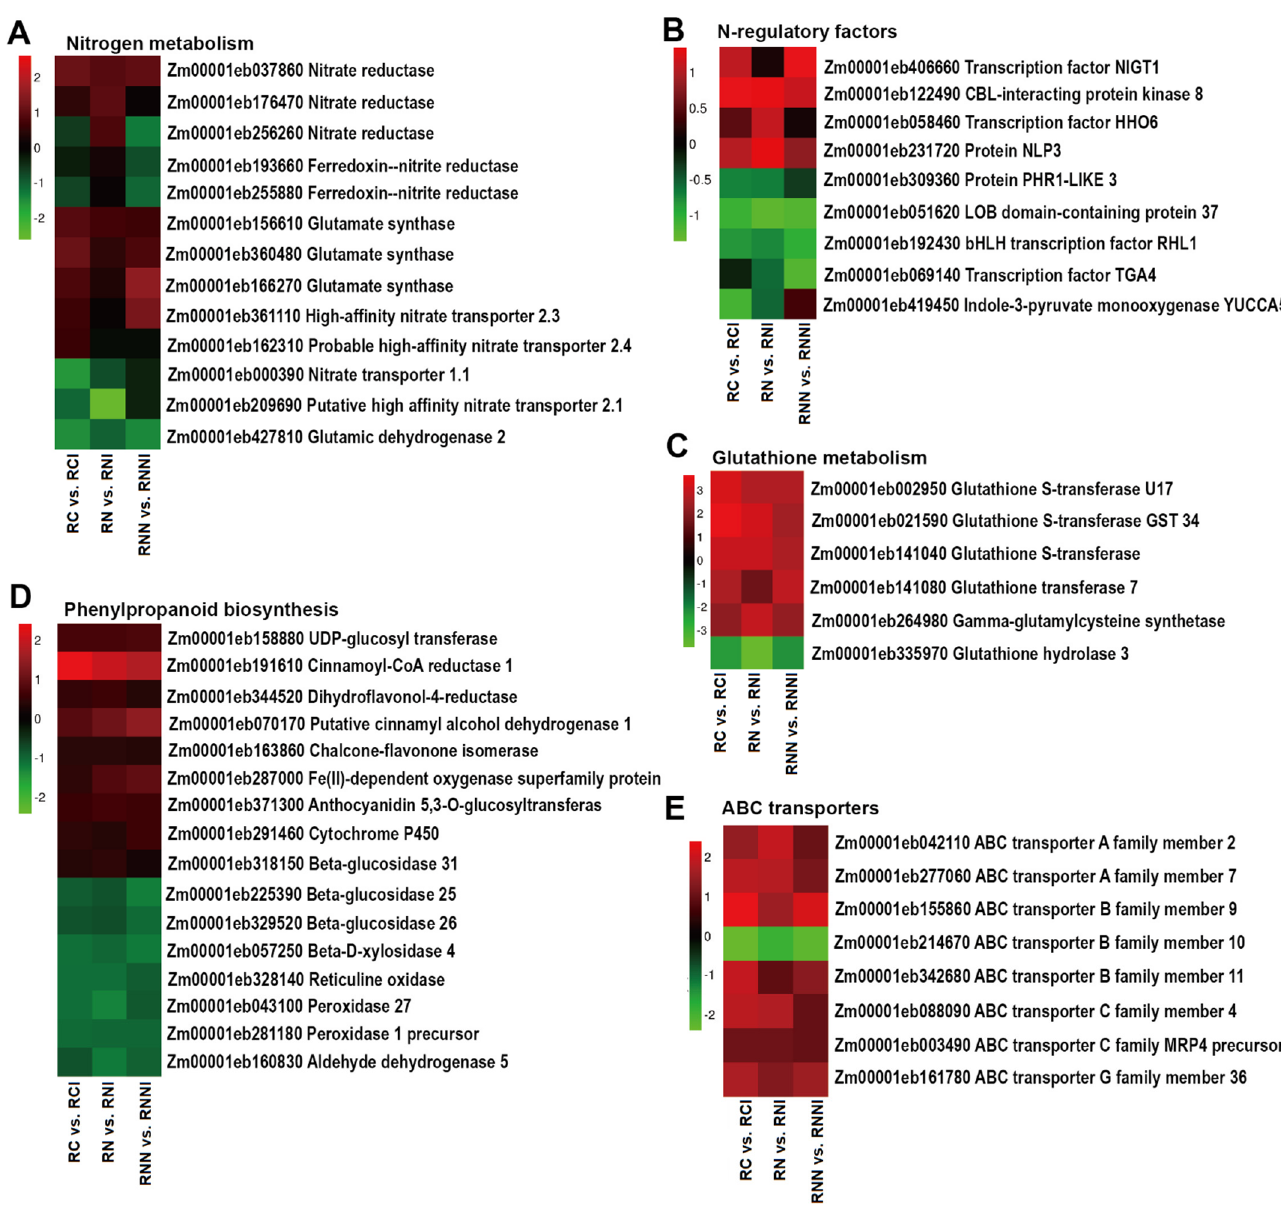
Figure 6. Putative DEGs involved in nitrogen metabolism ( A ), nitrogen-regulatory factor ( B ), glutathione metabolism ( C ), phenylpropanoid biosynthesis ( D ) and ABC transporter ( E ) in roots. Green to red means a down-regulated level to an up-regulated level (logFC).